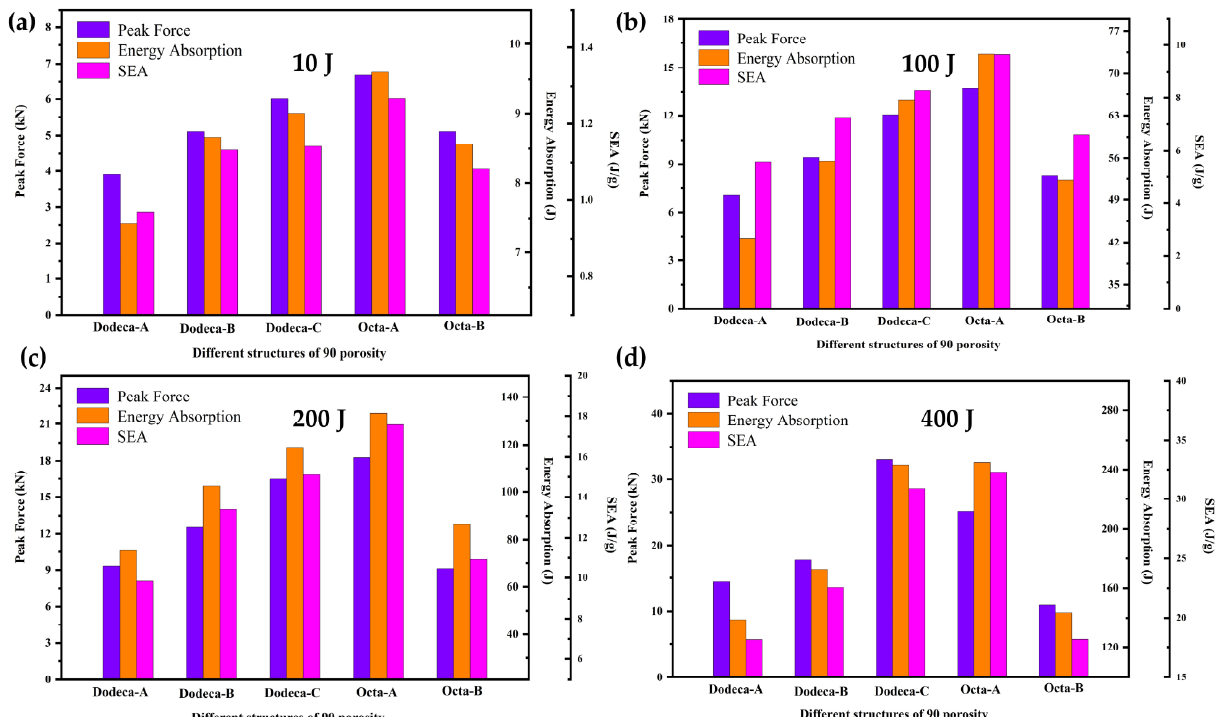
Figure 7. Comparison of energy-absorption indices of 90%-porosity structures under impact energy: ( a ) 10, ( b ) 100, ( c ) 200 and ( d ) 400 J.